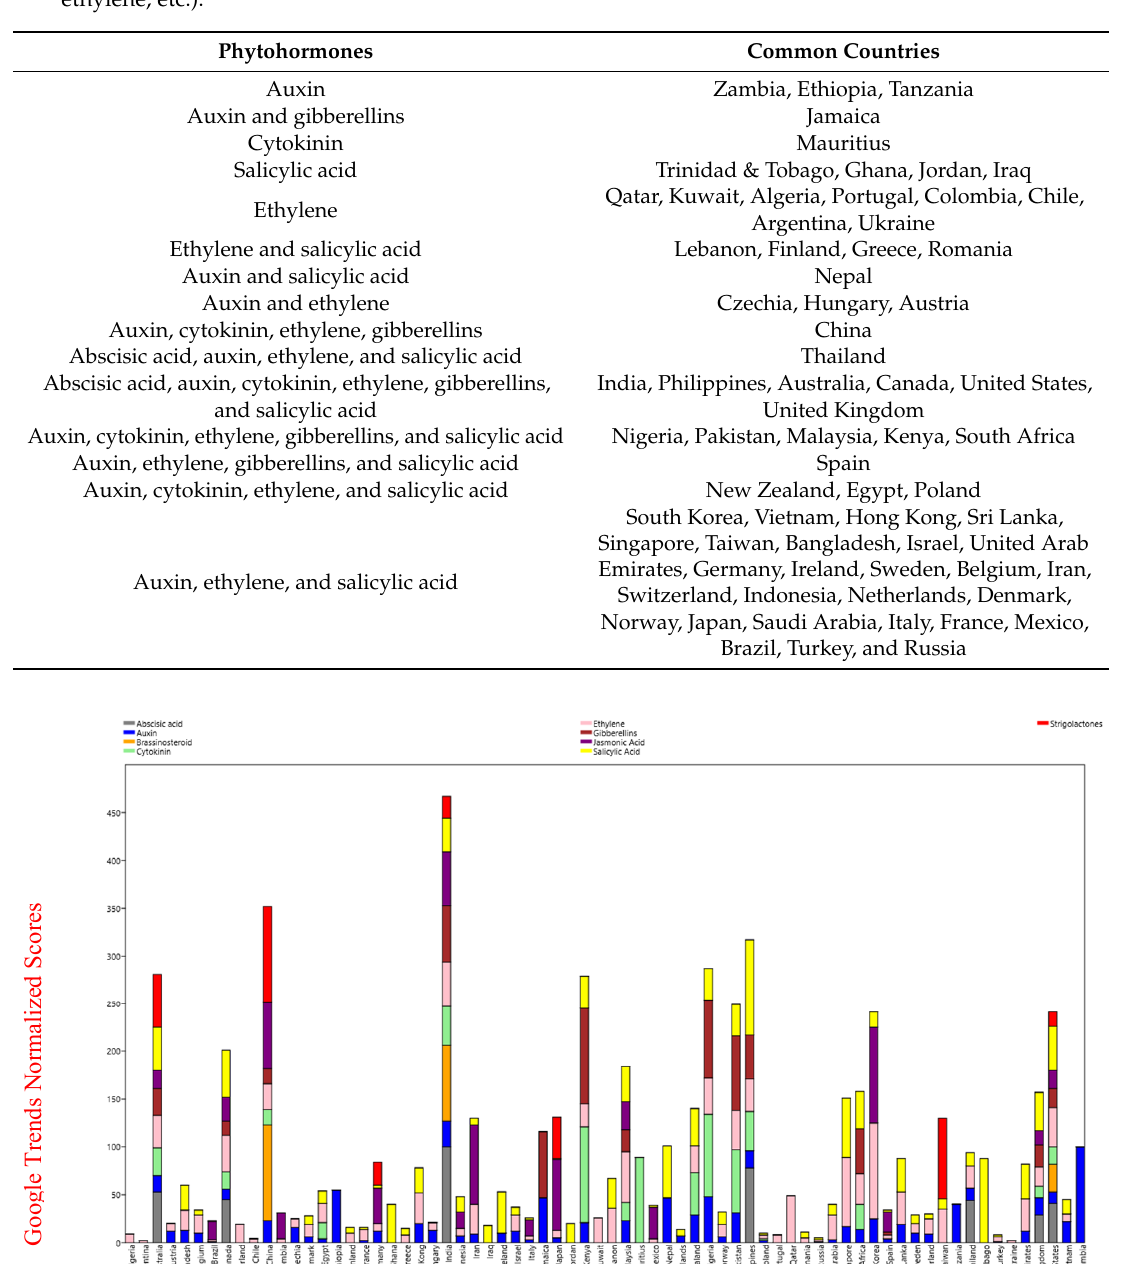
Table 3. Venn diagram result of the common countries of phytohormone searches with di ff erent phytohormone combinations. Six phytohormones, auxin, abscisic acid, cytokinin, ethylene, gibberellins, and salicylic acid were taken into consideration during this study. Phytohormone auxin was found in Zambia, Ethiopia, and Tanzania, whereas cytokinin was found only in Mauritius as these countries were not found in the search results for one or other phytohormones (e.g., gibberellins, cytokinin, ethylene, etc.).